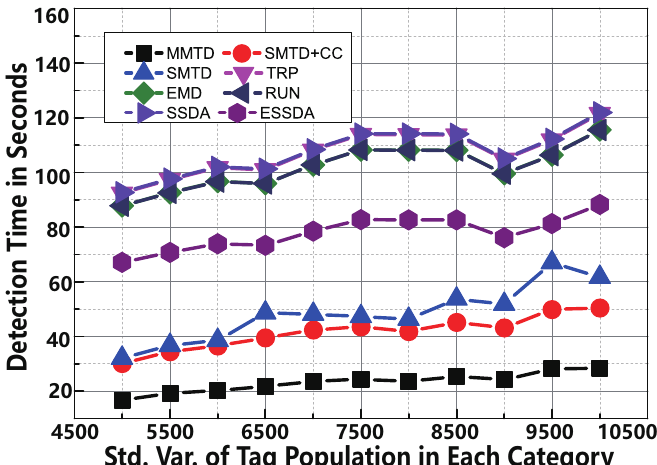
Figure 7. The comparison of time-efficiency between MMTD and other missing tag detection proto- cols when σ is set to be from 5000 to